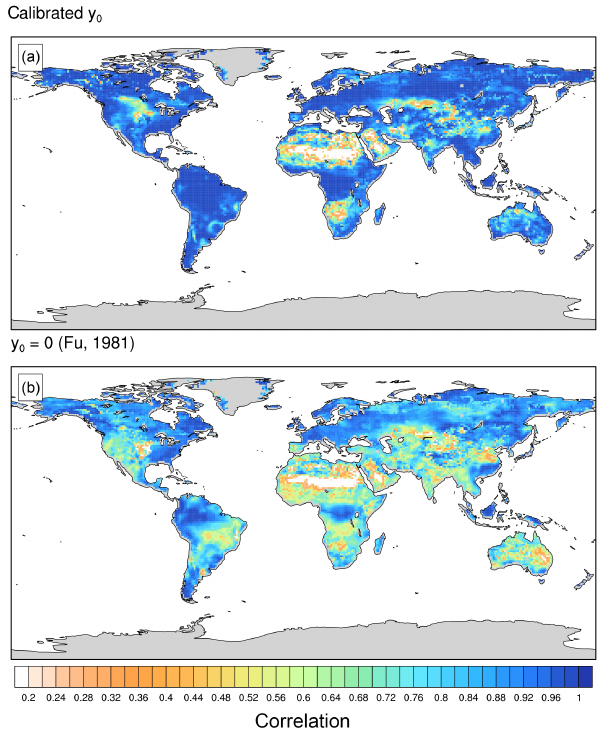
Figure 8. Correlation between the mean seasonal cycle of E/P computed from Eq. (9) and observed E/P for (a) a grid-point- specific parameter set ( κ , y 0 ) and (b) ( κ , 0) (Fu’s equation).